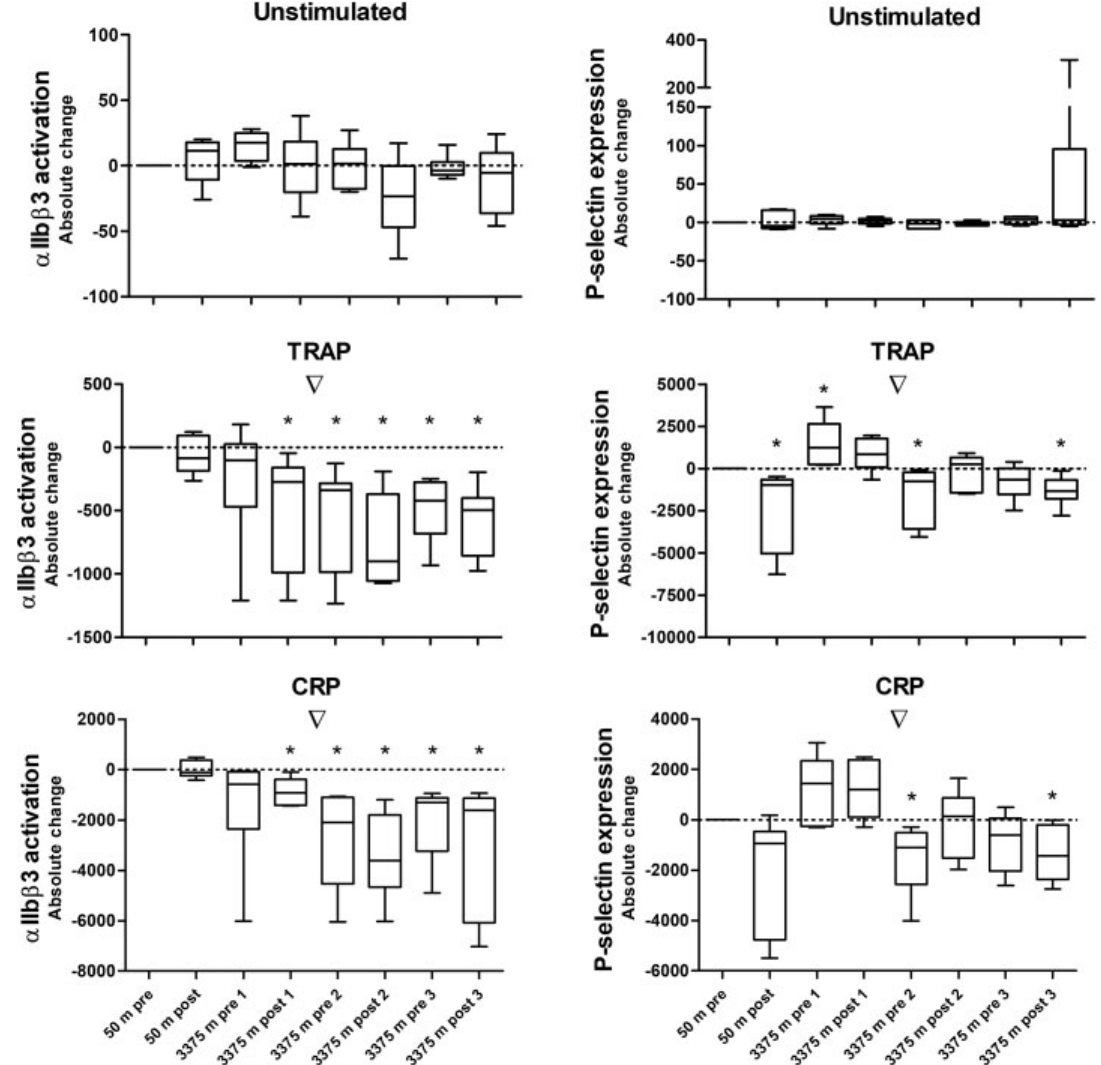
Fig.5 In fl uence of normoxic and hypoxicexercises on platelet activation. Platelet activation was measured beforeandafter 2hours of strenuous exercise, once at 50 m and three times at 3,375m altitude. Platelets were stimulated with the agonist thrombin receptor-activating peptide (TRAP, 30 μ mol/L, middle panels ) and collagen-related peptide (CRP, 5 μ g/L, bottom panels ). An unstimulated condition was included as a control ( top panels ), showing no signi fi cant differences in baseline platelet activation between participants. Platelet activation was measured as α IIb β 3 activation and P-selectin expression in median fl uorescence intensity. Results are expressed as the absolute change of 50 m pre-exercise; a value above 0 indicates an increase, and a value below 0 indicates a decrease. 5 ¼ p < 0.05 (Friedman ’ s test); (cid:5) ¼ p < 0.05 compared with zero (Wilcoxon signed-rank